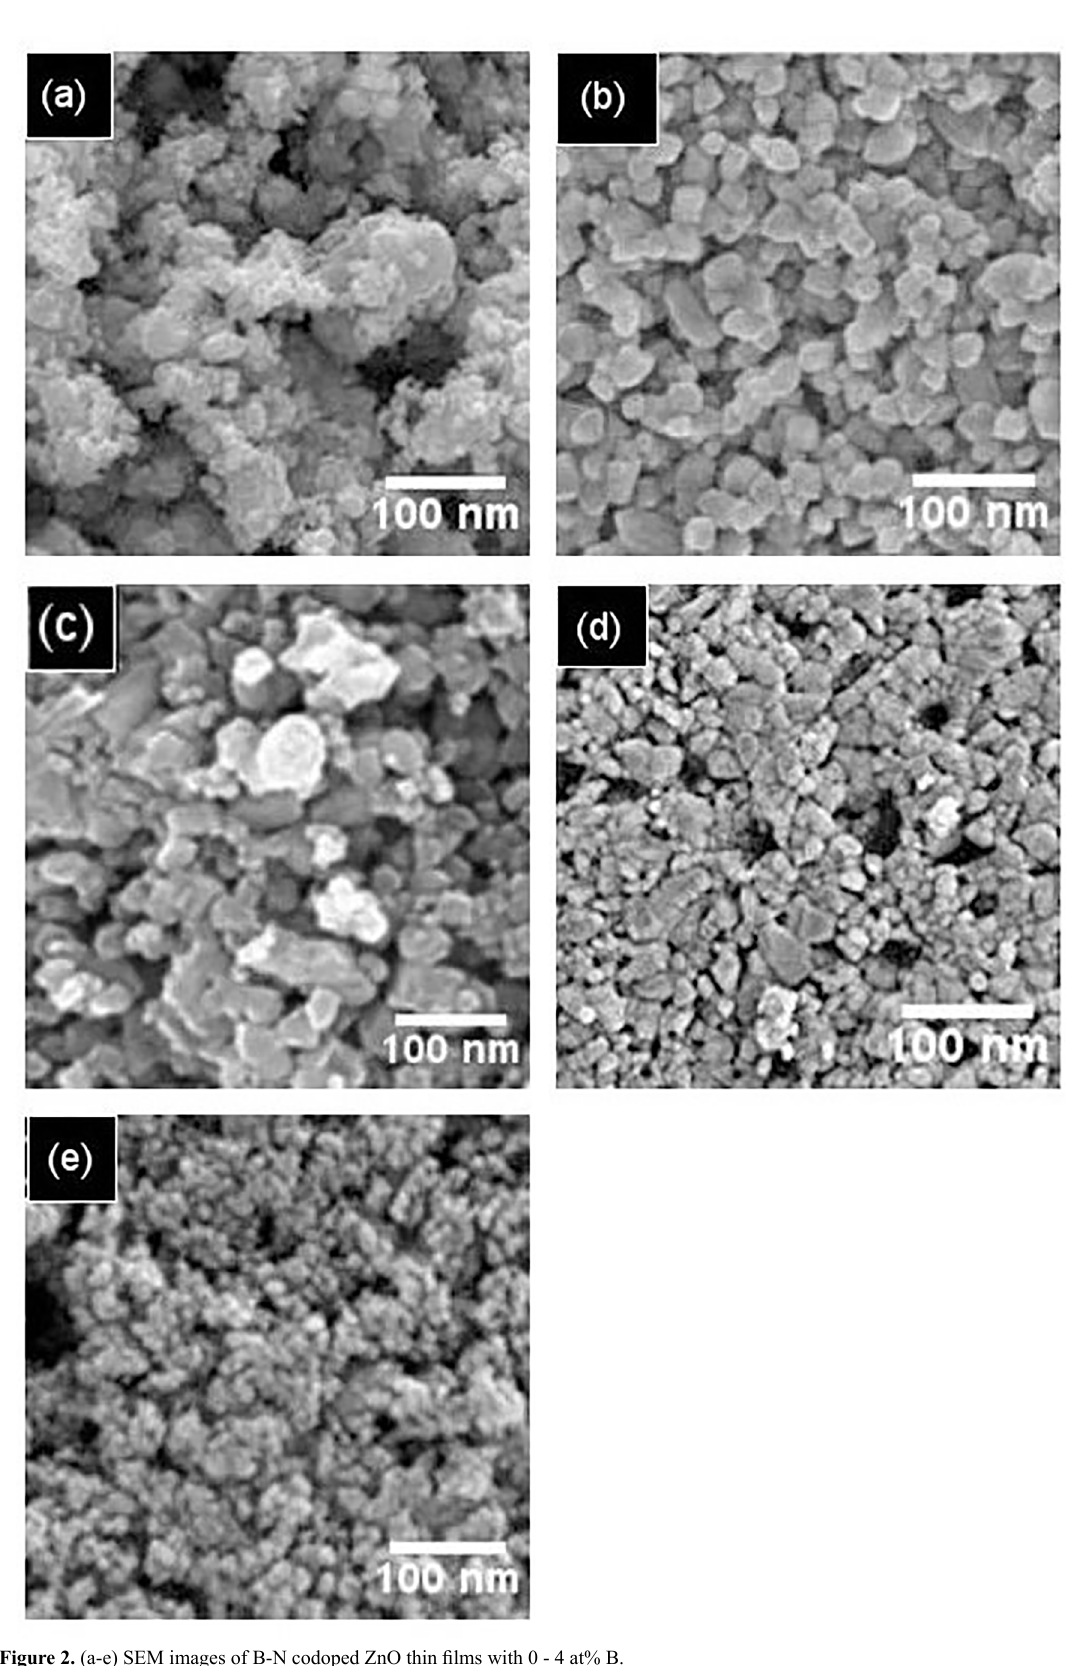
Figure 2. (a-e) SEM images of B-N codoped ZnO thin films with 0 - 4 at%